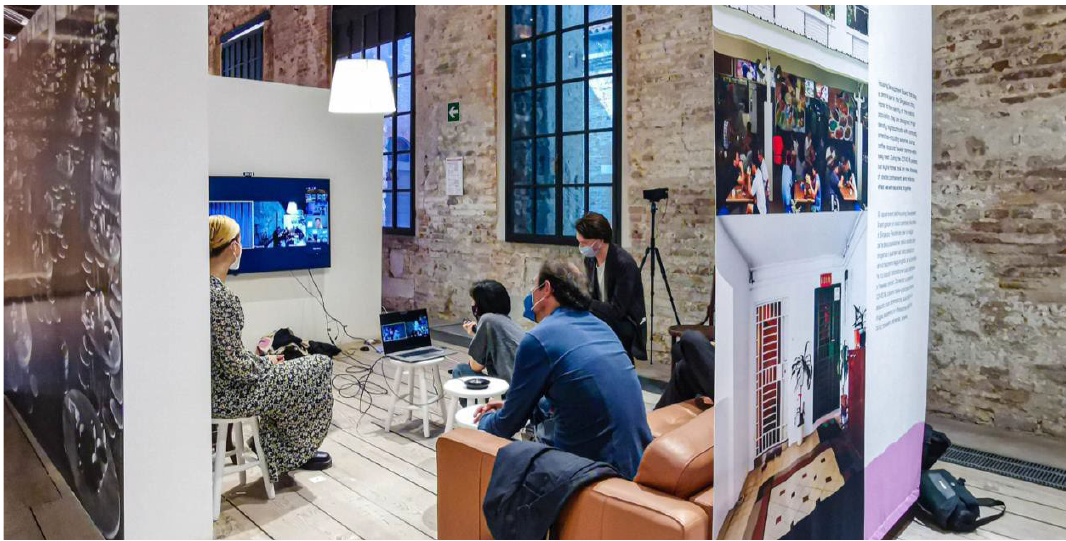
Figure 4 Final review at the Singapore Pavilion between Venice and Singapore participants on